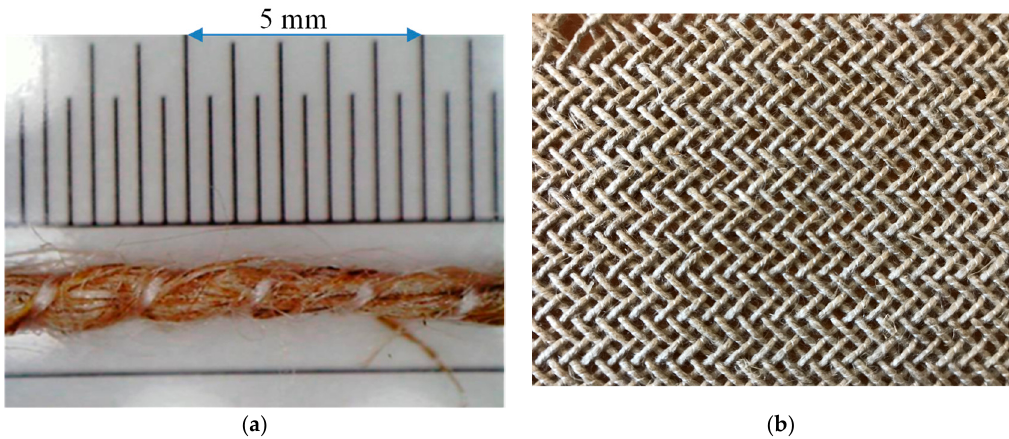
Figure 1. ( a ) Microscopic picture of Flax/PA12 commingled yarn and ( b ) Structure of 2-2 twill with Flax/PA12 commingled yarn. Flax/PA12 commingled